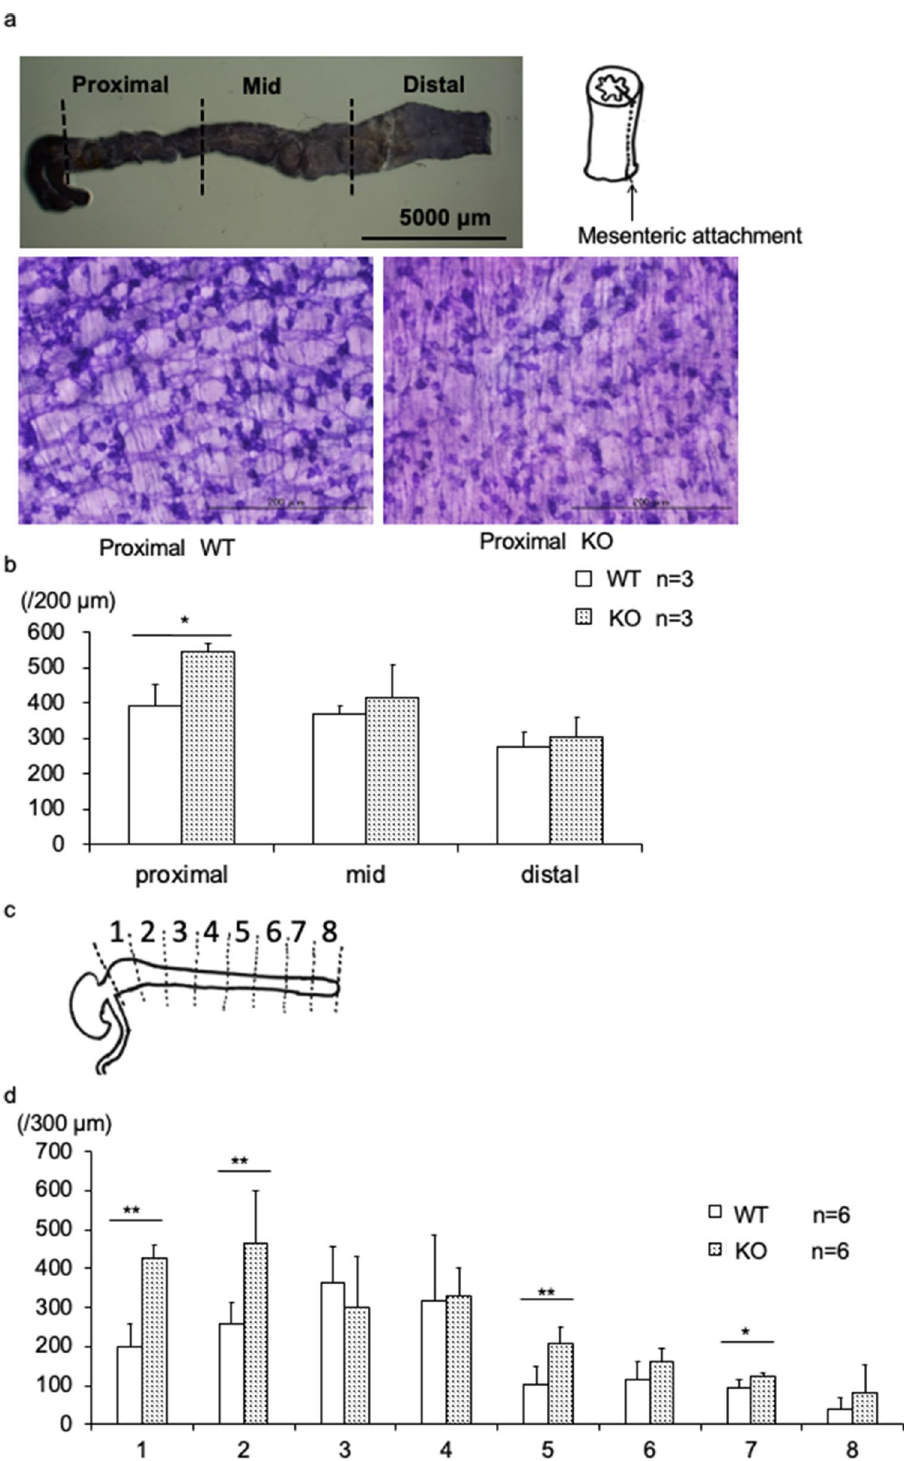
Figure 4. Number of NADPH-diaphorase (NADPH-d) positive enteric neurons in BALB/c Kif26a-KO mice. ( a ) Sample preparation from 4-day-old mice. The colon was divided into three parts (proximal, middle, and distal) and incised along a line following the points of mesenteric attachment. ( b ) Number of NADPH-d positive neurons in 200-μm-wide sections of proximal, middle, and distal colon from 4-day-old WT (open bars) and KO mice. ( c ) Sample preparations from 7-week-old mice. The colon was divided into eight parts and incised along the points of mesenteric attachment. ( d ) Number of NADPH-d positive neurons in 300-μm-wide section of colon divided into eight portions from 7-week-old WT (open bars) and KO